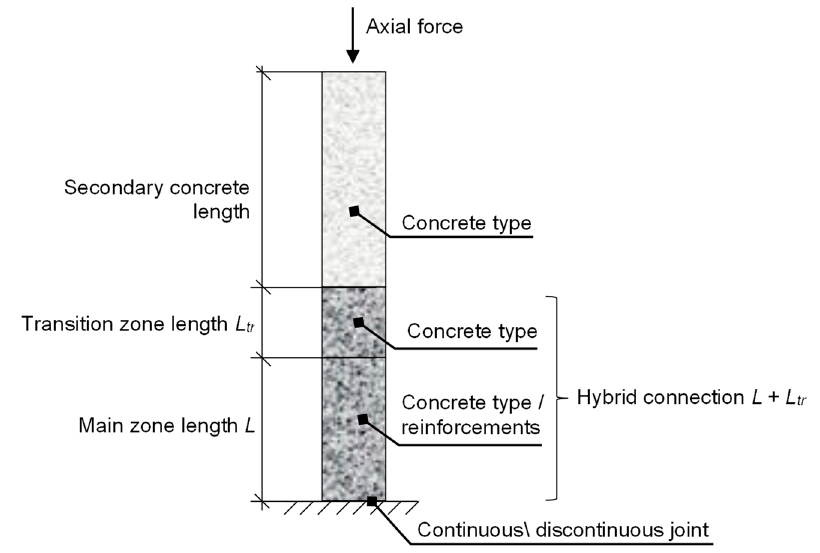
Figure 8. The parameters analyzed in the numerical simulation.